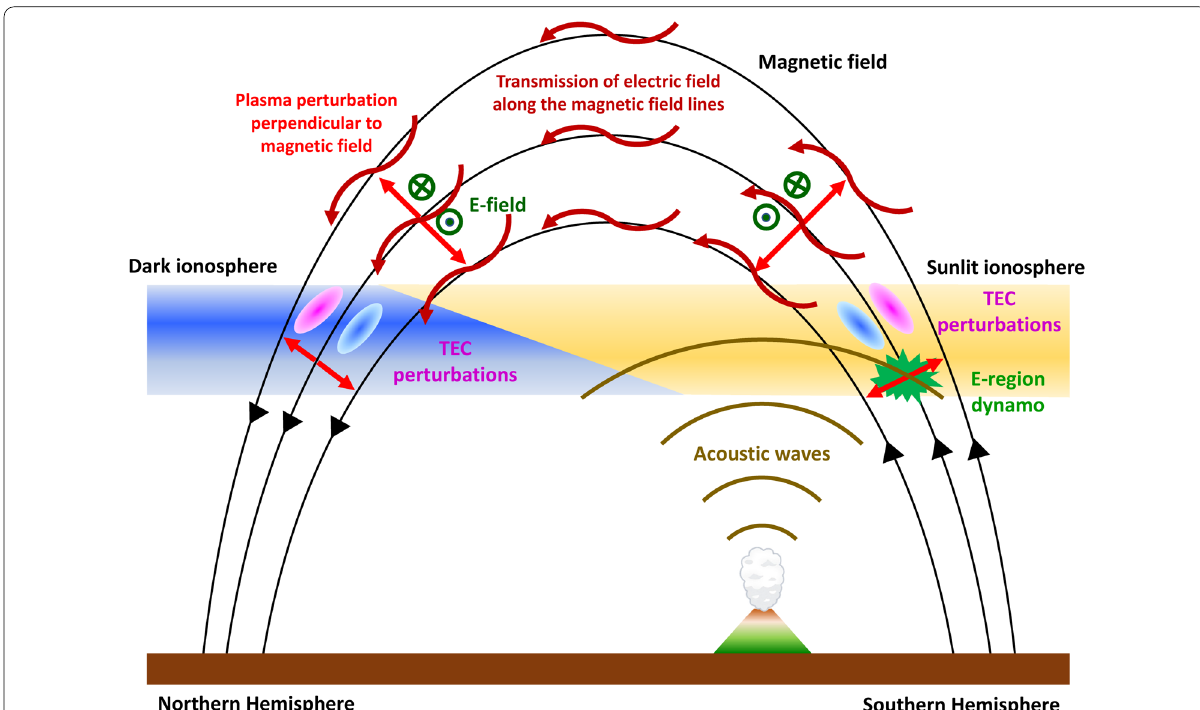
Fig. 9 A schematic view of scenario of TEC and electric field perturbations in the ionosphere triggered by the Tonga volcanic eruption as seen in GNSS-TEC and SuperDARN radar observations. The red arrows perpendicular to magnetic field lines indicate the plasma flow variations driven by the eastward and westward electric fields. The pink and blue circles represent the positive and negative TEC perturbations,